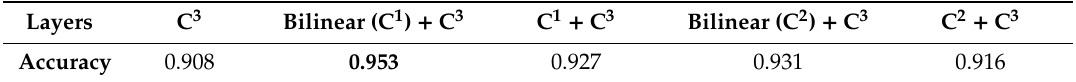
Table 4. The accuracy of di ff erent combinations of two